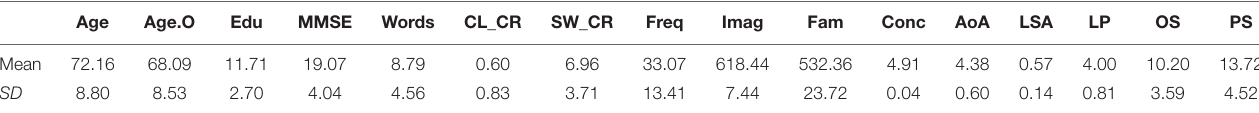
TABLE 1 | Demographics, total words, and mean values for clusters, switches, and word properties for animal fluency in our sample of people with AD. Age Age.O Edu